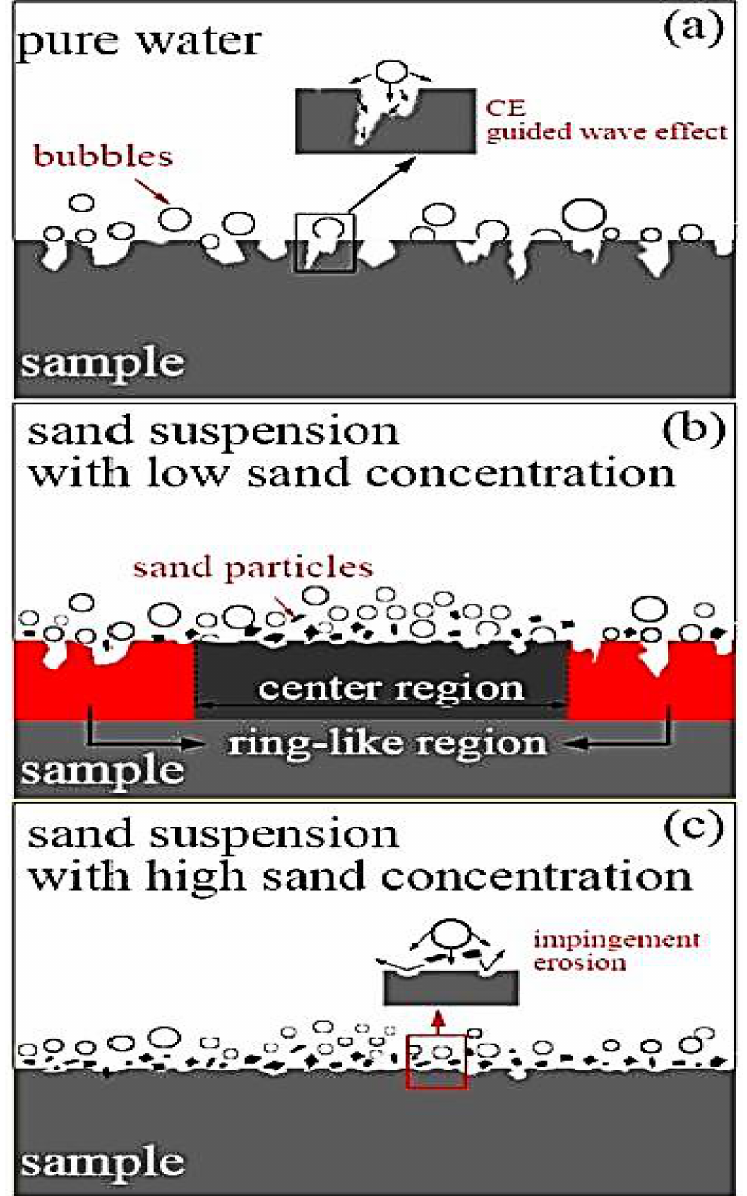
Figure 4. CE and CSE mechanisms ( a – c )